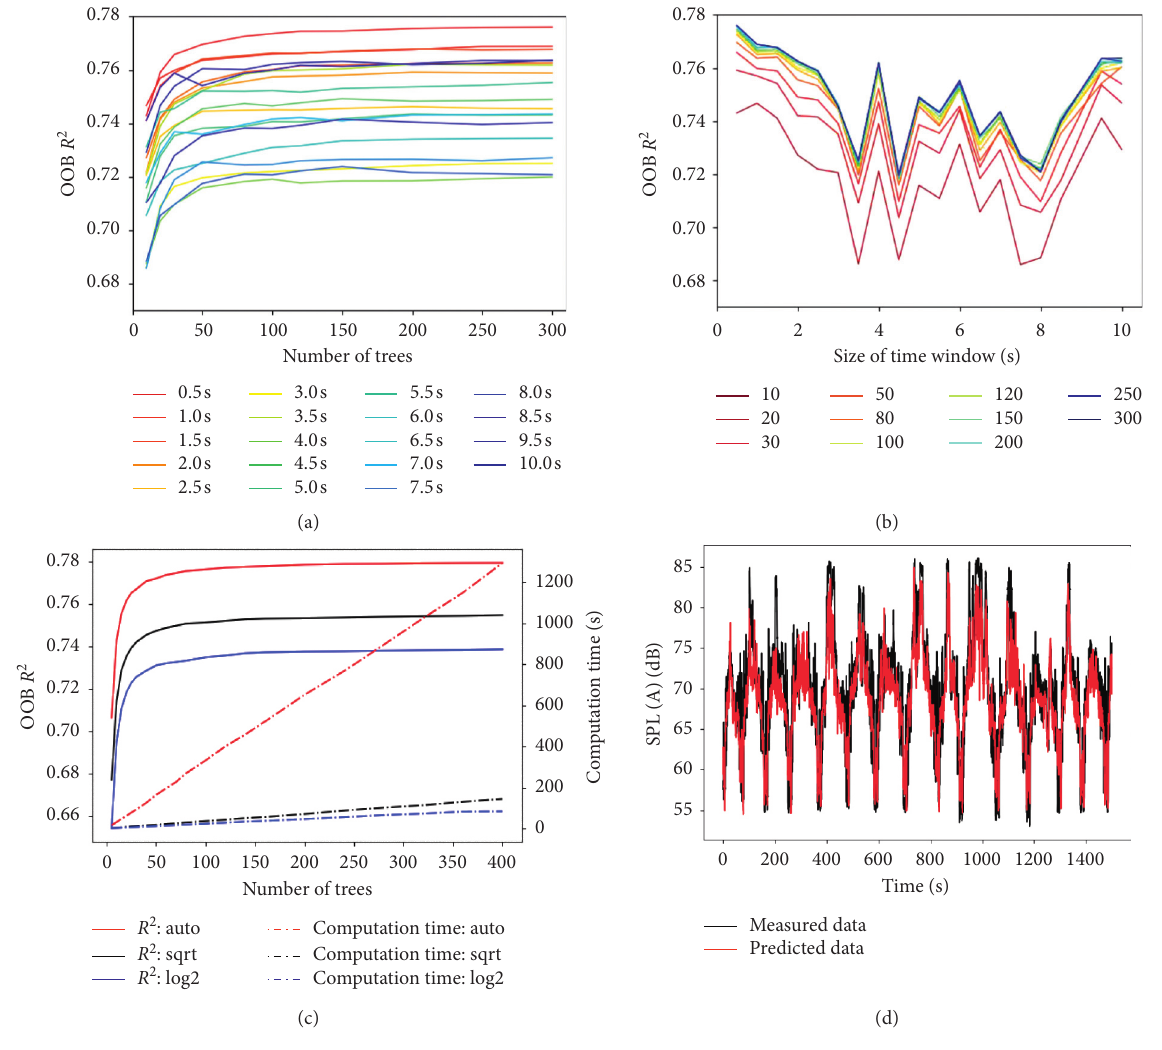
Figure 4: Effect of number of estimators on OOB R 2 .